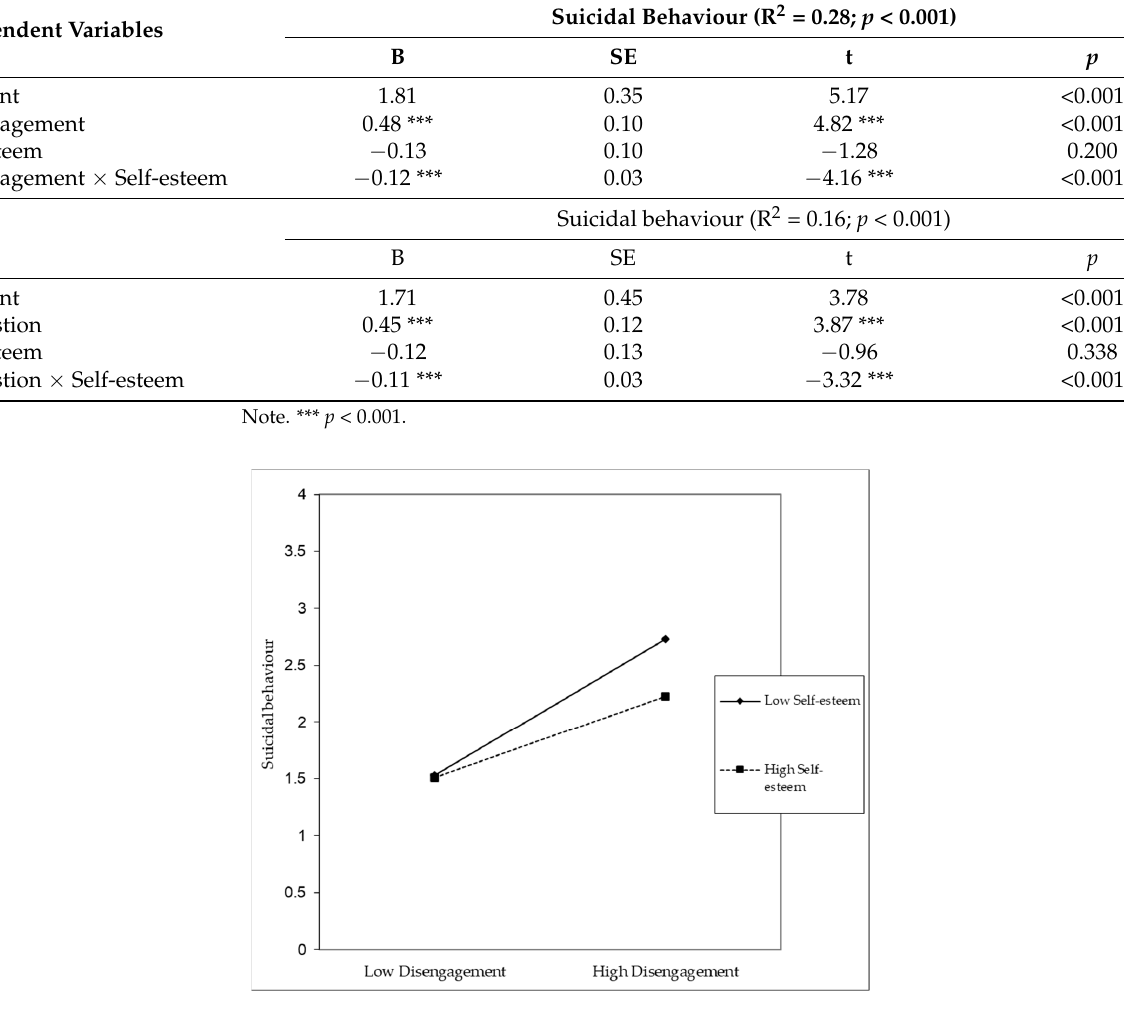
Figure 7. Disengagement × self-esteem interaction effect (B = − 0.12; p < 0.001) .